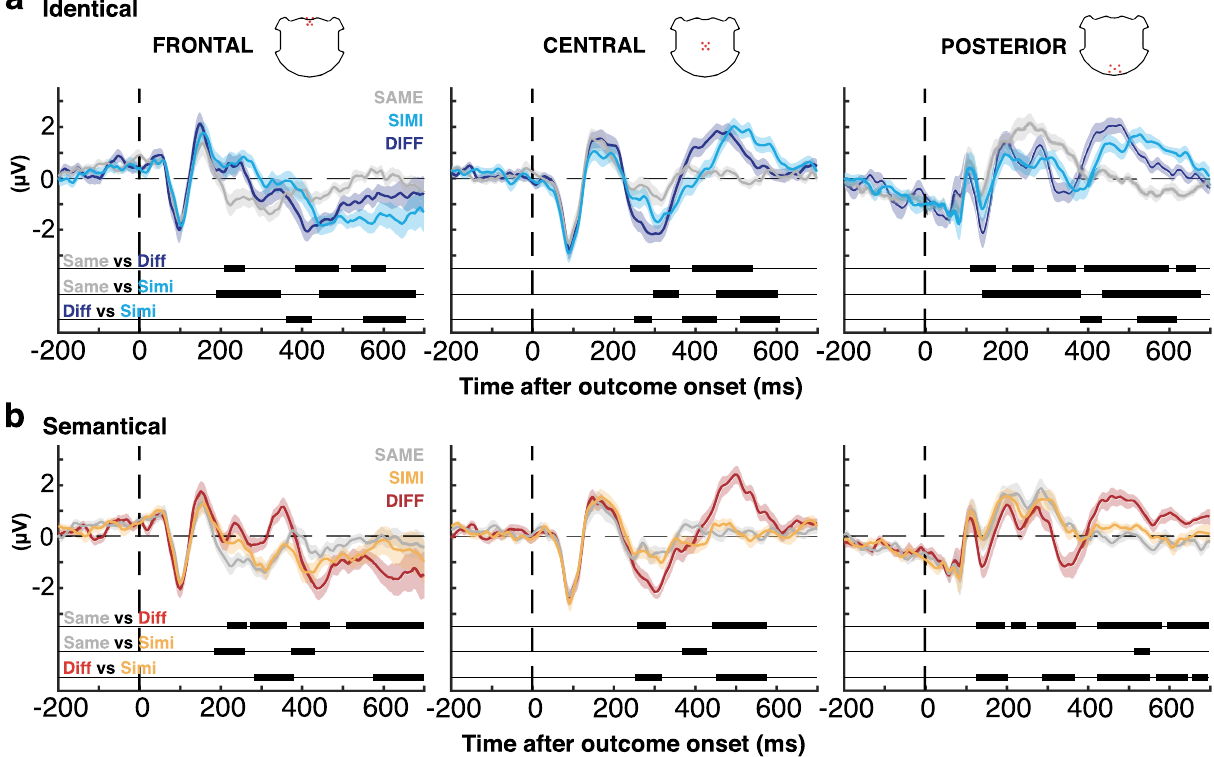
Figure 3. Cluster waveforms analysis. The curves show averaged potentials evoked by presentation of outcomes SAME, SIMI and DIFF, in condition identical ( a ) and condition semantical ( b ), at three clusters of five electrodes; frontal (left), central (middle) and posterior